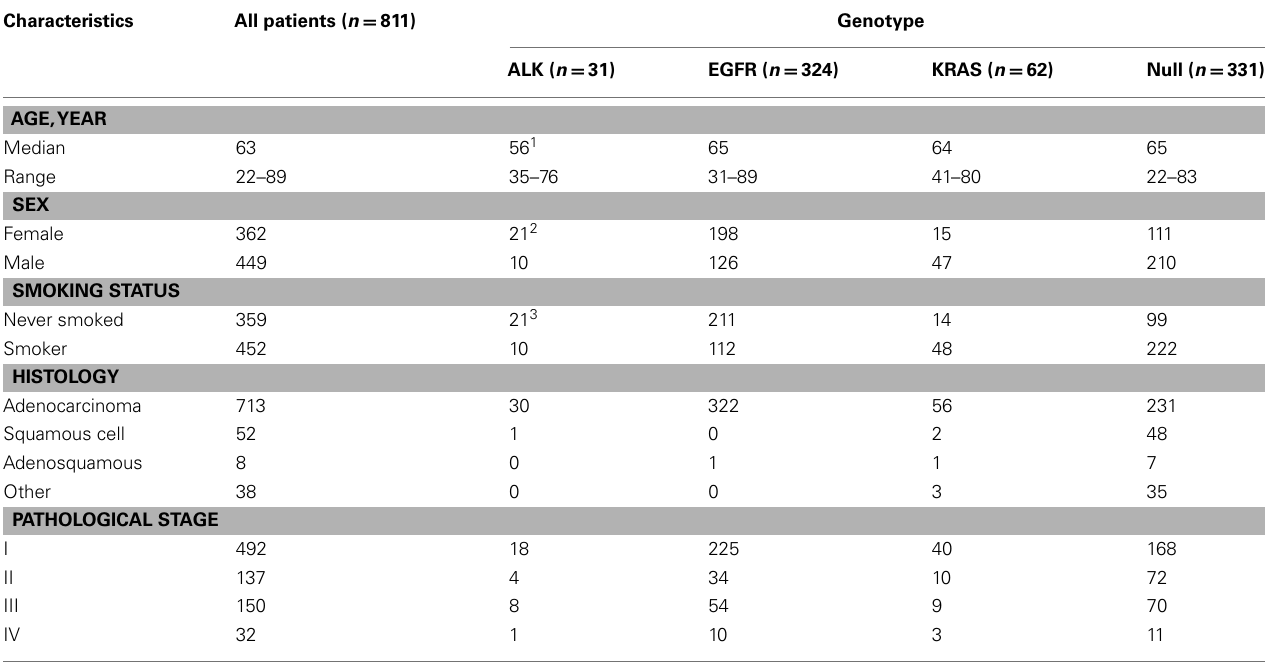
Table 1 | Clinicopathological characteristics ofALK-positive lung cancers.